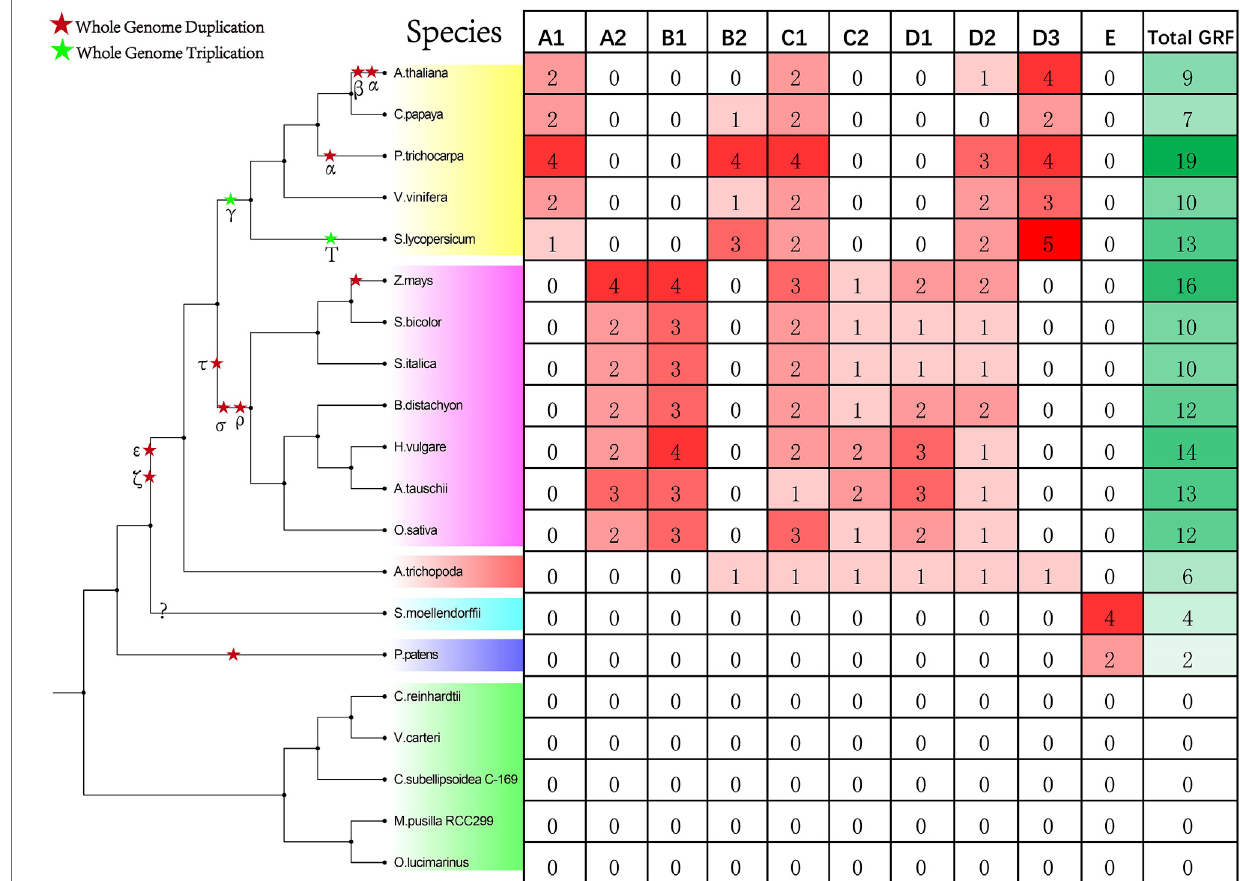
FIGURE 1 | The number of GRF families in the collected species. The left of this fi gure shows the evolutionary relationships of the species; the right of this fi gure shows the number detail of the GRF family of each species.